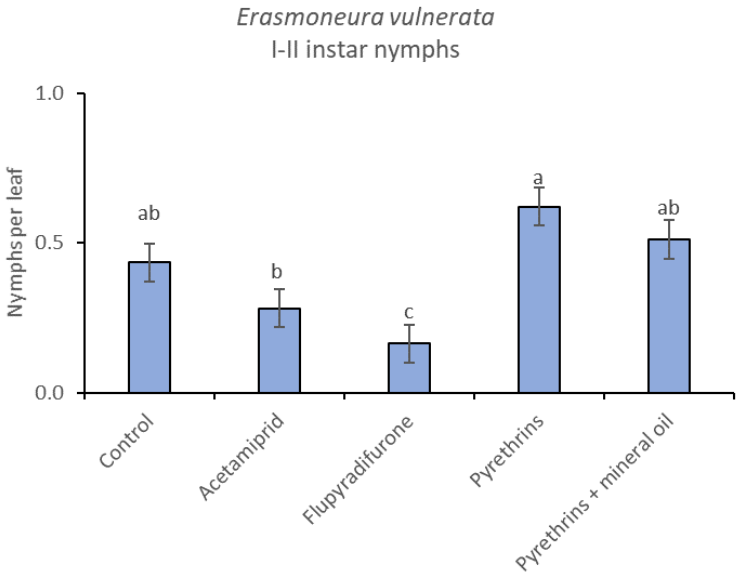
Figure 15. Least-square means ( ± std. err.) of Erasmoneura vulnerata early (I-II instar) nymphs observed on different treatments in the 2019 trial. Different letters indicate significant differences at t -test (α = 0.05.).